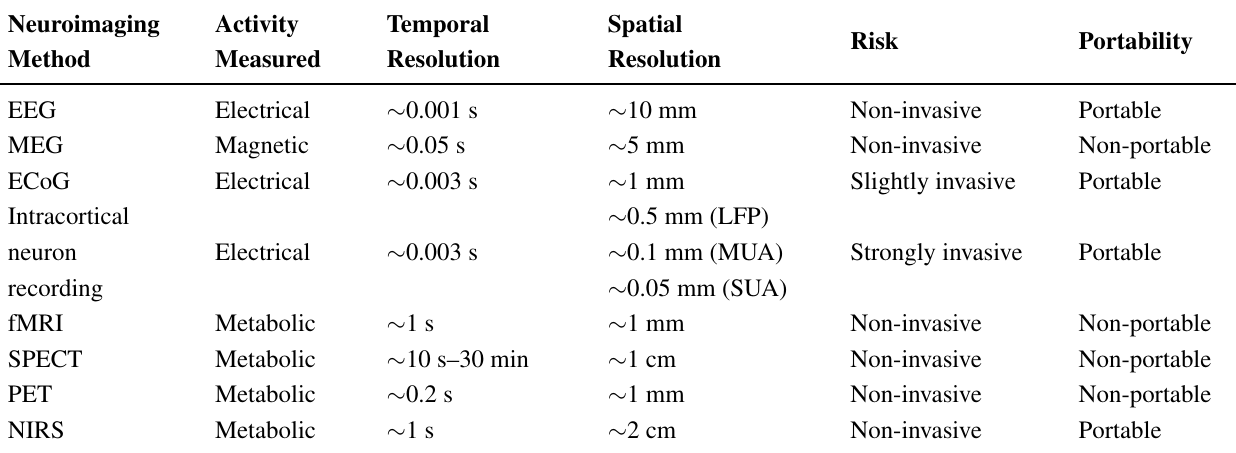
Table 2. An overview of neuroimaging methods. Direct methods detect